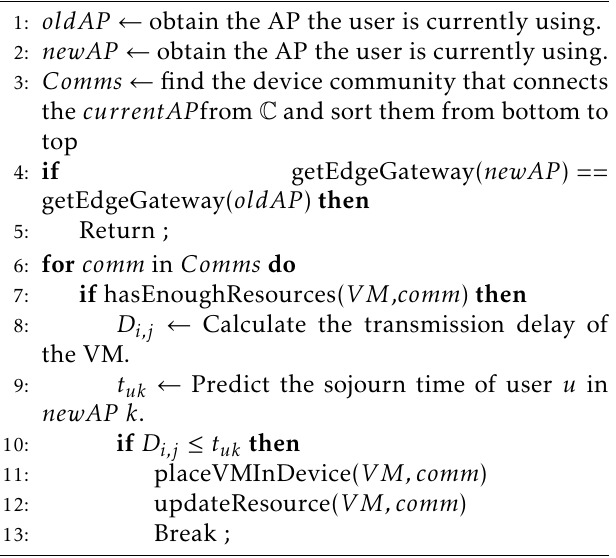
Algorithm 2 Algorithm 2 Virtual machine migration